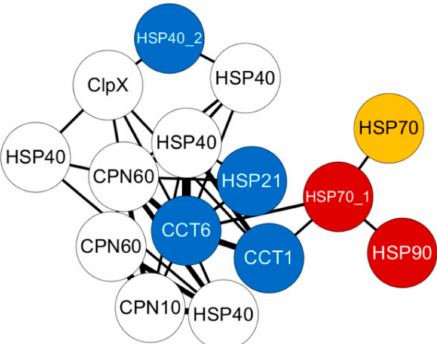
Figure 6. Weighted gene co-expression network analysis (WGCNA) co-expression network derived from Module 3, which only includes annotated HSP genes. The sub-network of turquoise, from gill tissue was plotted using Cytoscape, with edge weight ≥ 0.2. Colored circles indicate di ff erentially expressed genes (yellow), genes selected for qRT-PCR (blue), and di ff erentially expressed genes selected for qRT-PCR